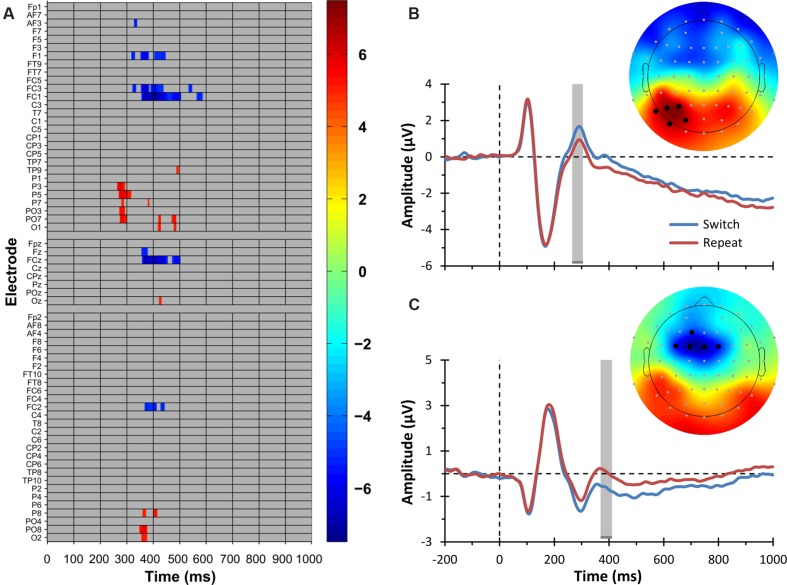
Electrophysiological results: switching main effect.
(A) Raster diagram showing significant differences between ERPs elicited by switch and repeat trials (i.e., the ERP switch effect) according to the tmax permutation test. Rectangles in warm and cold colors indicate electrodes/time points in which the ERPs to switch trials are more positive or negative, respectively. The colorbar on the right indicates t values. Gray rectangles indicate electrodes/time points at which no significant differences were found. Note that the electrodes are organized along the y-axis somewhat topographically (Groppe et al., 2011a). Electrodes on the left side of the head are grouped on the top part of the diagram, those on the right side on the bottom, and midline electrodes are shown in the middle. Within those three groupings, the y-axis top-to-bottom corresponds to scalp anterior-to-posterior. (B) The trace plot depicts the grand average ERPs to switch and repeat trials pooled over the electrodes showing the parieto-occipital ERP switch effect, namely, P3, P5, P7, PO3, and PO7. These electrodes are indicated as black circles in the topographical map on the right. The topographical map shows the t values for the parieto-occipital ERP switch effect in a 30-ms time window centered on the time point at which the ERP switch effect was maximal. This time window is indicated by the gray shaded region in the ERP plot. The color scale is the same as that of the raster diagram. (C) The trace plot depicts the grand average ERPs to switch and repeat trials pooled over the electrodes showing the frontal ERP switch effect, namely, F1, FC3, FC1, FCz, and FC2. These electrodes are indicated as black circles in the topographical map on the right. The topographical map shows the t values for the frontal ERP switch effect in a 30-ms time window centered on the time point at which the ERP switch effect was maximal. This time window is indicated by the gray shaded region in the ERP plot. The color scale is the same as that of the raster diagram. Note that the time windows indicated by the gray shaded regions in (B,C) are the same as those used in the source estimation analysis (see Figure 5).